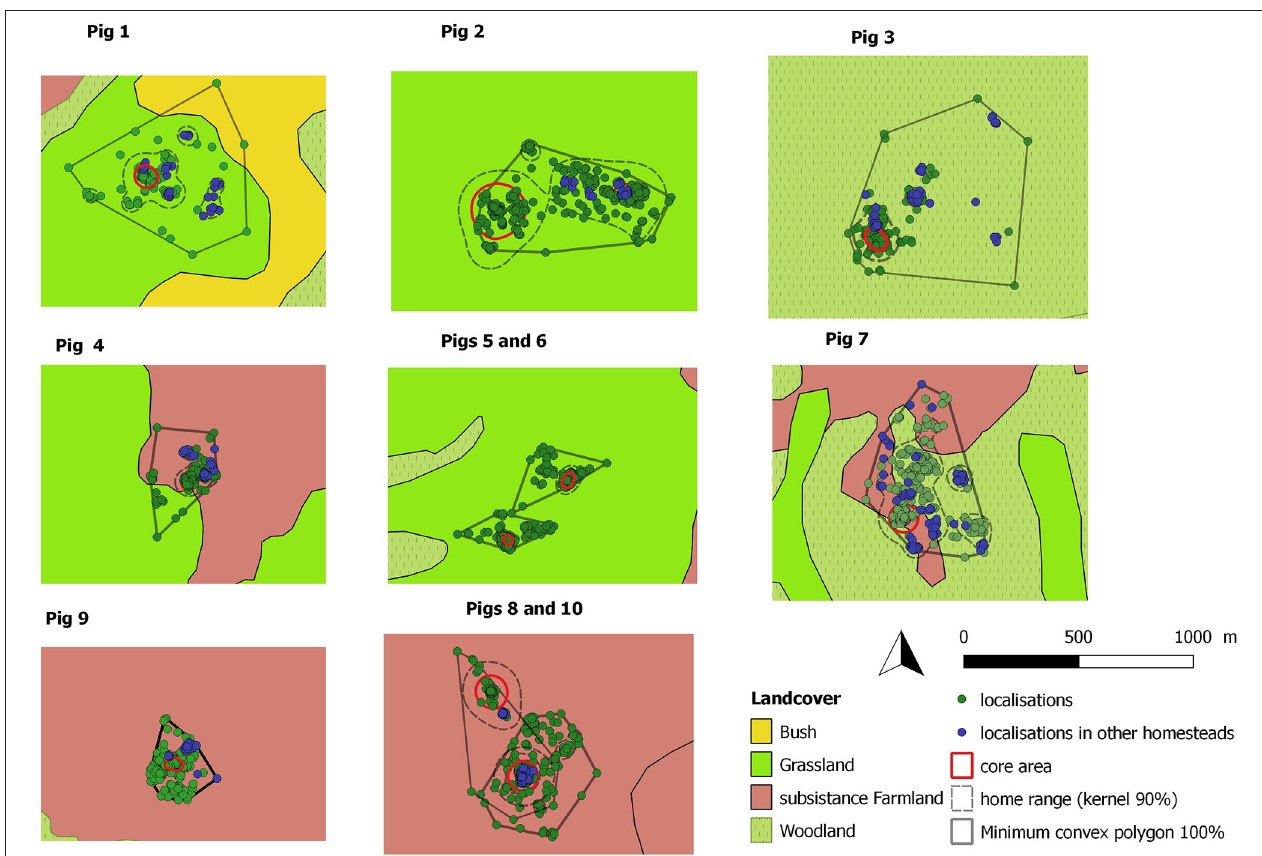
FIGURE 3 | Collected locations, home ranges and core areas used by the 10 monitored pigs plotted on the different landcover types. Pigs 1, 2, 7, 8, 9, 10 were monitored during the dry season and pigs 3, 4, 5, 6 during the rainy season. The use of habitat was not studied for pig 10. The blue dots localized in his home range corresponds to pig 8’s